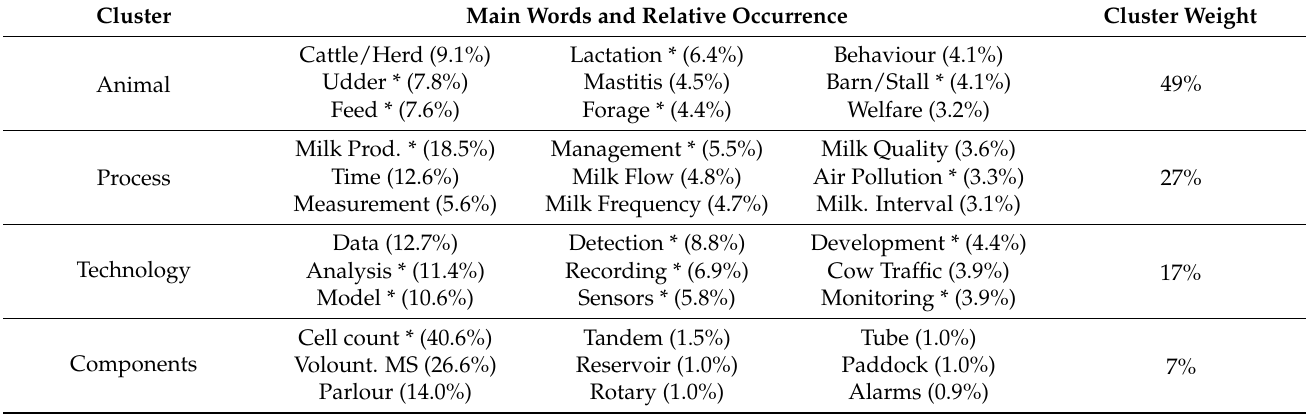
Table 3. Conceptual clusters derived from the analysis of papers. The main words of each cluster, along with their frequency, is reported in the second column. Words marked with an asterisk have undergone the stemming process, which consists of including in a single lemma all variant forms of the same word (i.e., images and imaging, or udder and teats). In most cases stemming was applied to words with common root (e.g., lactation and lactating); in some cases, stemming was applied to words with the same meaning (e.g., udder and teat).